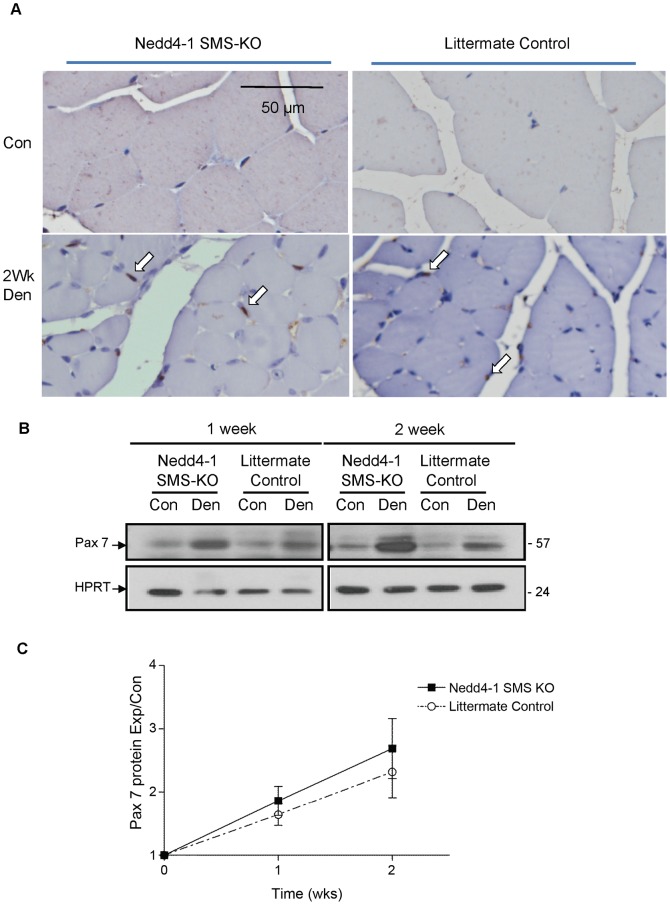
Satellite cell/myoblast population is increased in denervated gastrocnemius muscle.(A) Cross sections of gastrocnemius muscle from Nedd4-1 SMS-KO and littermate MyoCre;Nedd4-1+/+ mice were immunostained for the satellite cell/myoblast marker Pax 7 (brown nuclei, indicated by white arrows). Myonuclei are counterstained purple with hematoxylin. There is an apparent increase in satellite cell number in the denervated gastrocnemius of both Nedd4-1 SMS-KO and littermate MyoCre;Nedd4-1+/+ control mice. (B) Similarly, representative Western blots (WB) of gastrocnemius protein lysates denervated for 1 week (left panel) and 2 weeks (right panel) show increased expression of Pax 7 in the denervated (Den) compared to the contralateral control (Con) muscle of Nedd4-1 SMS-KO and littermate MyoCre;Nedd4-1+/+ mice. HPRT served as loading control. (C) The chemiluminescent signal was quantified and Pax-7 protein levels were normalized to corresponding HPRT levels (lane matched). Normalized Pax-7 levels in denervated (Exp) muscle were expressed as a fraction of the normalized Pax-7 level in control (Con) muscle and these values are depicted in the graph. Pax-7 is significantly increased in the denervated gastrocnemius muscle of both Nedd4-1 SMS-KO and MyoCre;Nedd4-1+/+ mice at both 1 and 2 weeks post-tibial nerve transection (n = 6 mice/group, p<0.05), but there is no difference in the magnitude of the increase between Nedd4-1 SMS-KO and MyoCre;Nedd4-1+/+ mice. Data are presented as the mean ± SEM.